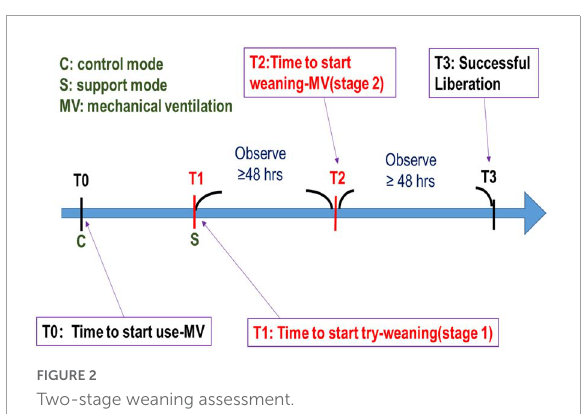
FIGURE2 Two-stage weaning